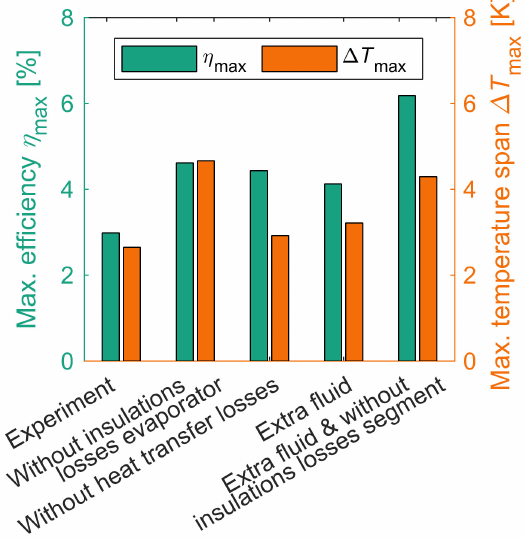
Figure 10. Efficiency of the AEH η at